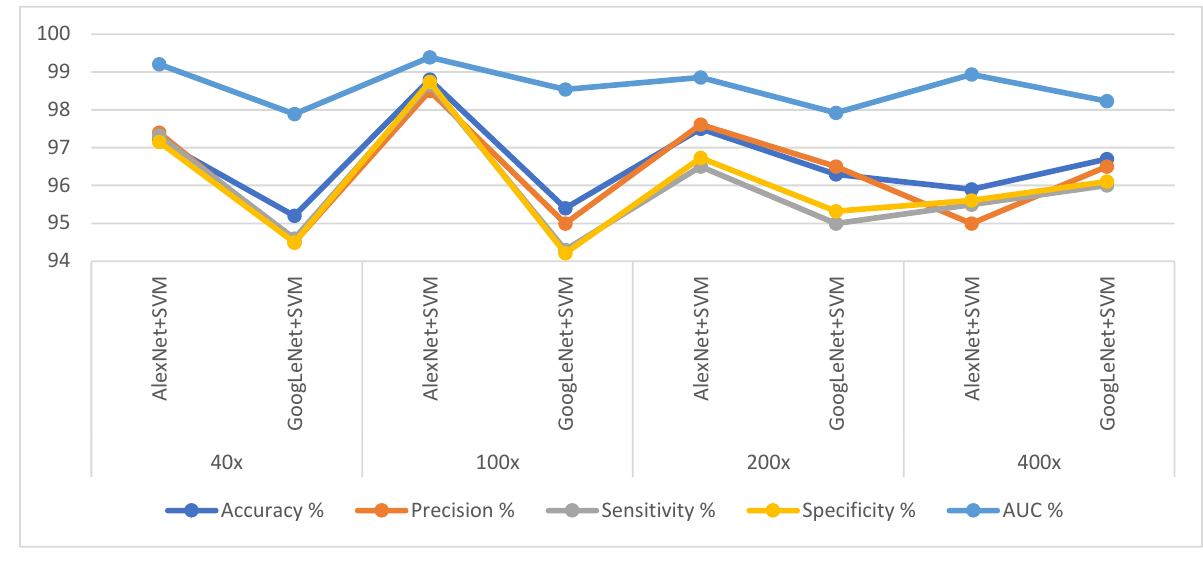
Figure 5. Evaluation of the BC dataset with MF: 40×, 100×, 200×, and 400×.